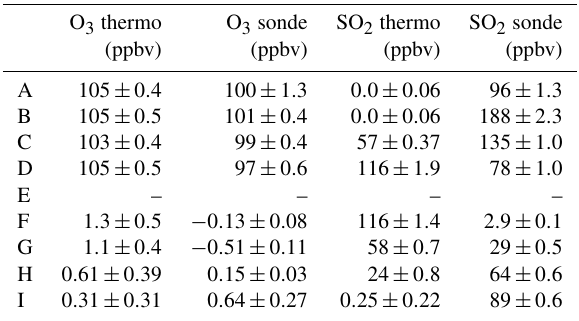
Table 1. Averaged O 3 and SO 2 concentration measured by the SO 2 sonde version 1.0 and Thermo instruments during different stages of testing indicated in Fig.